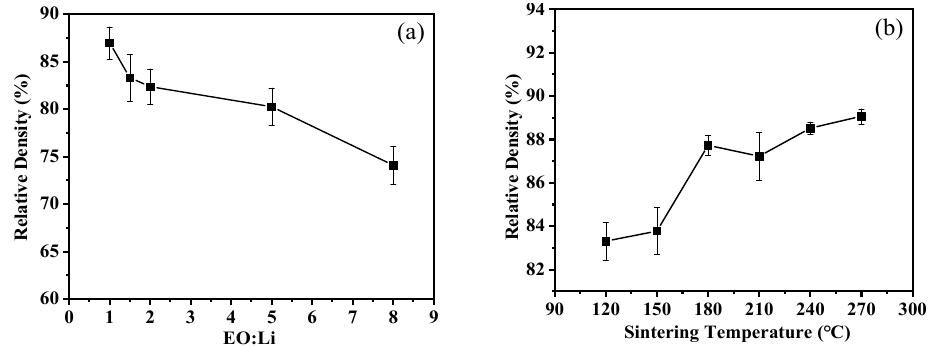
Figure 1. Relative density of ( a ) cold-sintered LLZTO composite electrolytes with different EO to Li molar ratios and ( b ) cold-sintered LLZTO-PEO 2 -LiTFSI composite electrolytes at different sintering temperatures.